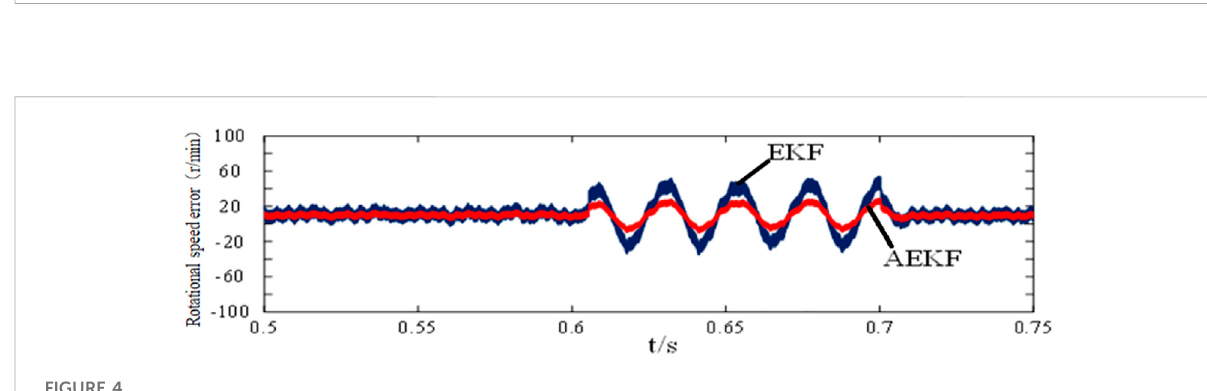
FIGURE 4 Speed error with external